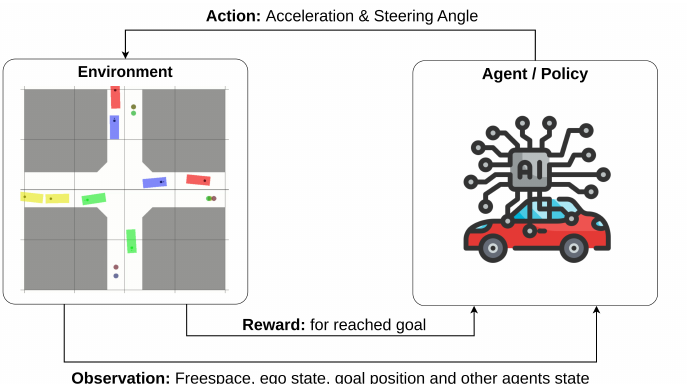
Figure 1. Scheme of agent–environment interaction used in our problem statement.